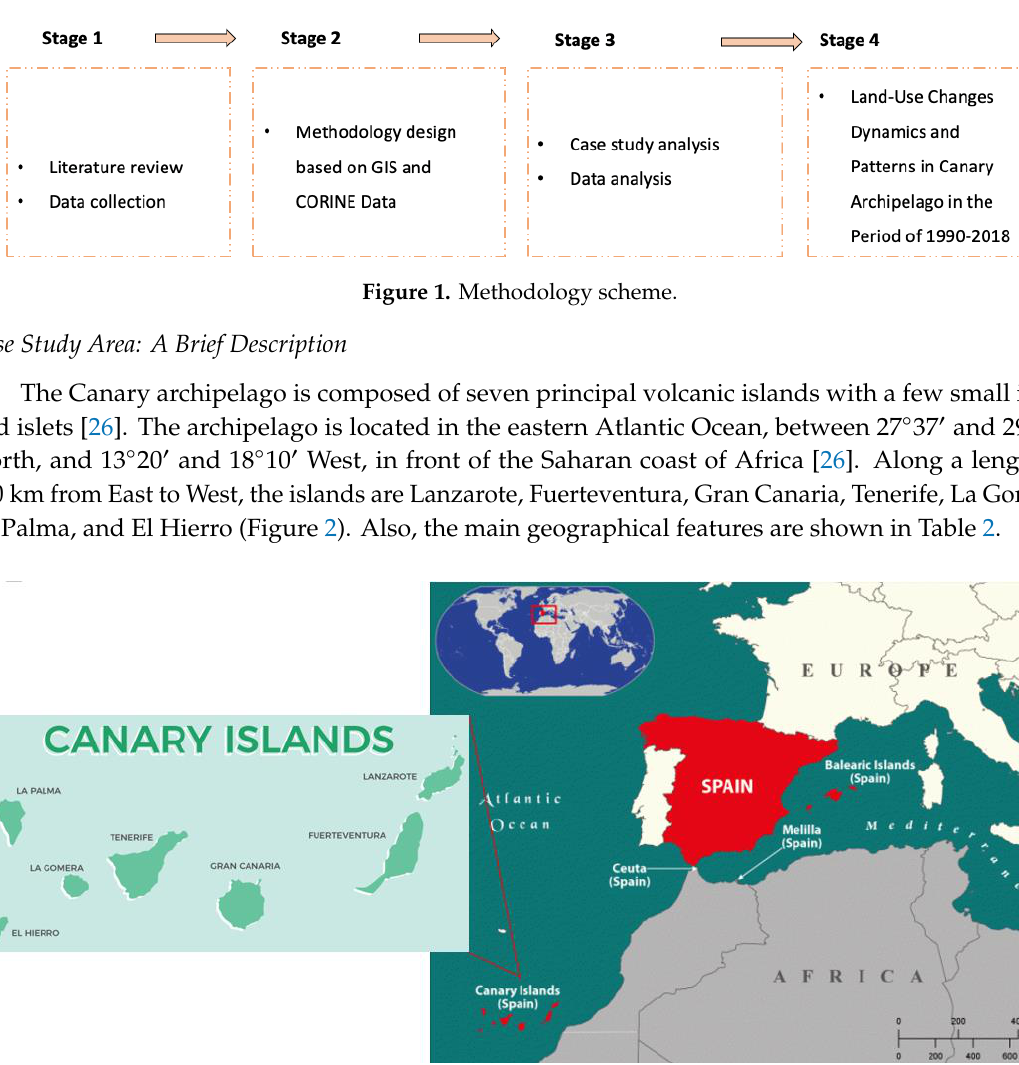
Figure 2. The Canary Islands (source: [27]). Table 2. General data on the Canary Archipelago Islands, adapted from Custodio et al. [28]. Island